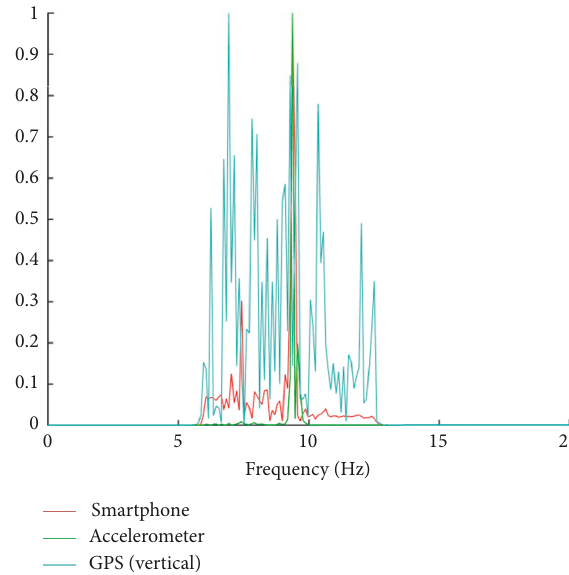
Figure 13: Dynamic frequencies in terms of periodogram (vertical